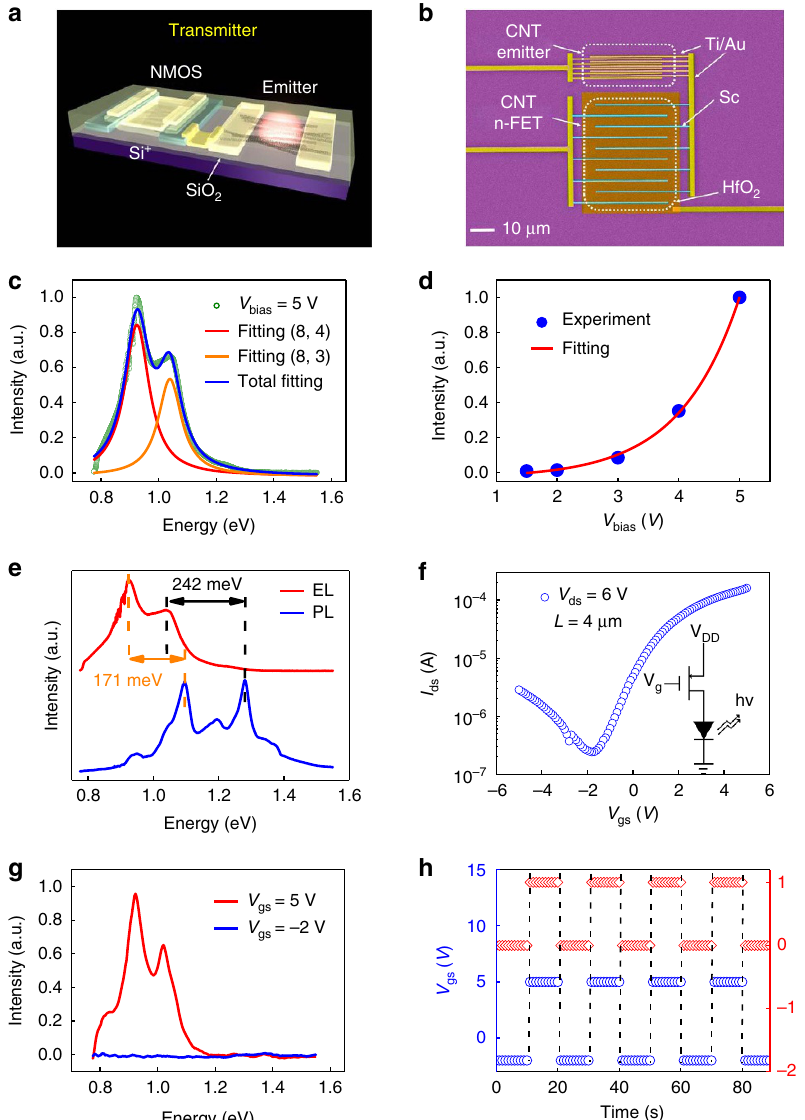
Figure 2 | Structure and performance of the CNT transmitter. ( a ) Schematic of the CNT transmitter consisting of a digital CNT n-FET (field effect transistor) and emitter. ( b ) False-colour SEM image of the real CNT transmitter (scale bar, 10 m m), consisting of an interdigital n-FET and emitter. ( c ) EL spectrum and Lorentzian fitting. ( d ) Integrated IR emission intensity as a function of voltage bias. ( e ) Corresponding EL and photoluminescence spectra. ( f ) Transfer characteristics of the CNT transmitter with a modest V ds ¼ 6V. Inset is the corresponding equivalent circuit diagram. ( g ) Tunable and controllable IR emission of the transmitter. The two EL emission spectra correspond to V gs ¼ (cid:3) 2 and 5V, respectively. ( h ) Time trace of the